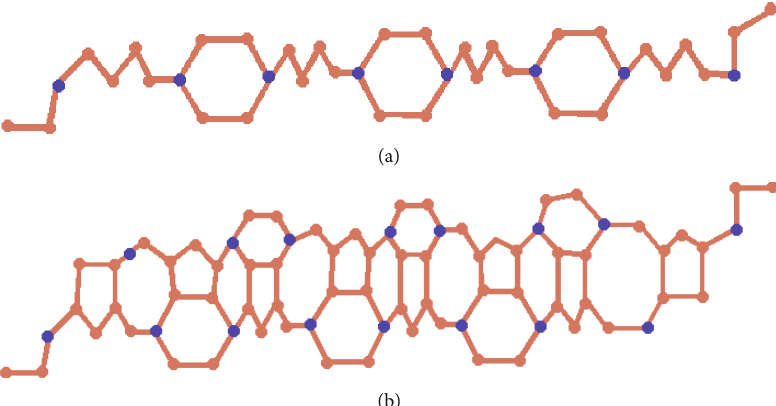
– II [3] where i = j = 3 . 4